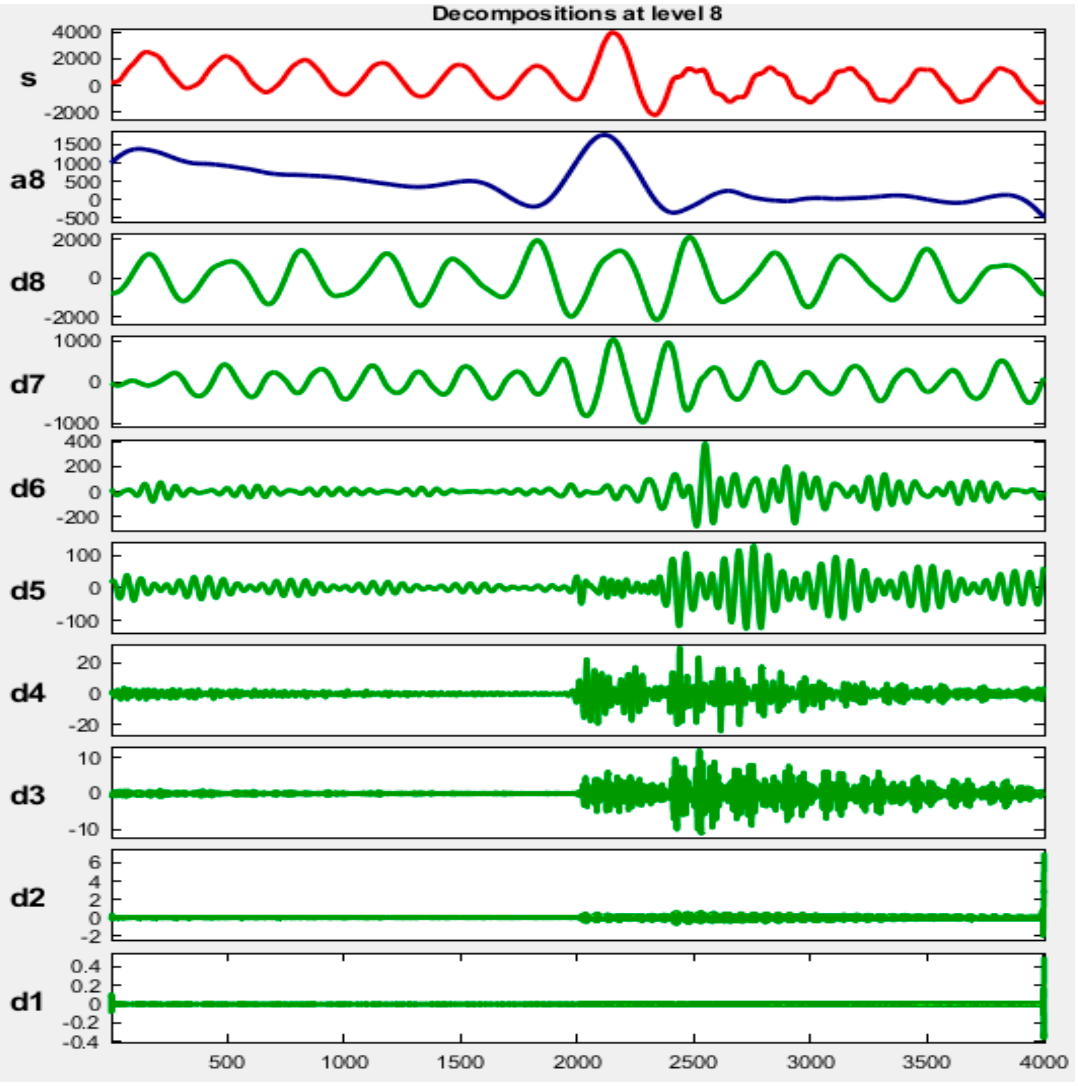
Figure 13. DWT analysis of Phase A during the LG fault with STATCOM compensation. Table 3. Current magnitude during normal conditions and faults at different locations without the